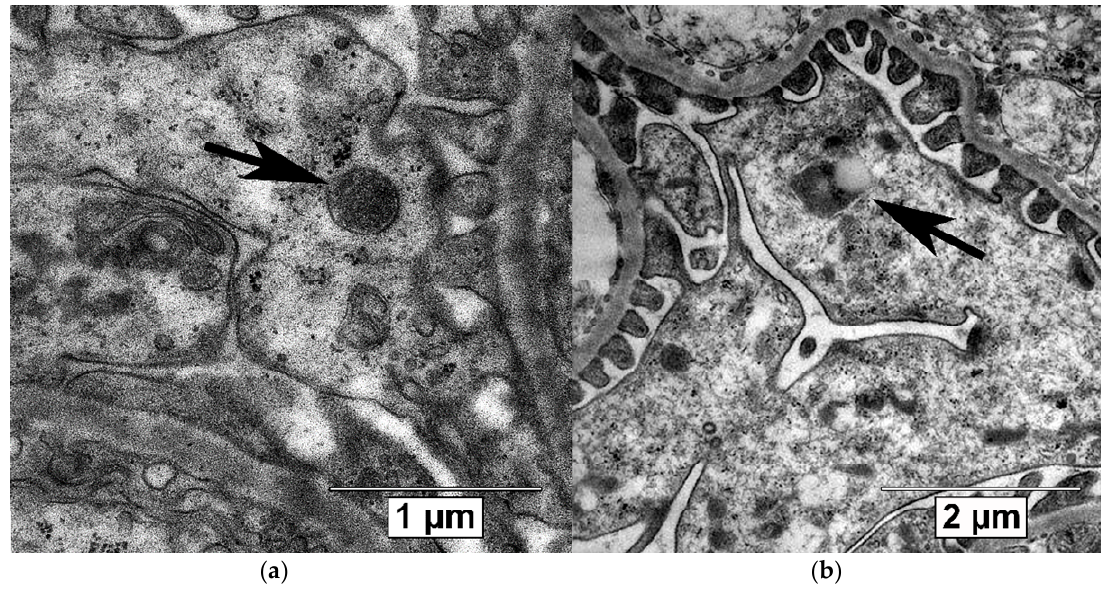
Figure 8. Autophagic compartments in mouse podocytes: lysosomes (black arrow, a ) and autolysosome (black arrow, b ). TEM, scale bars: 1 µm ( a ) and 2 µm ( b ).